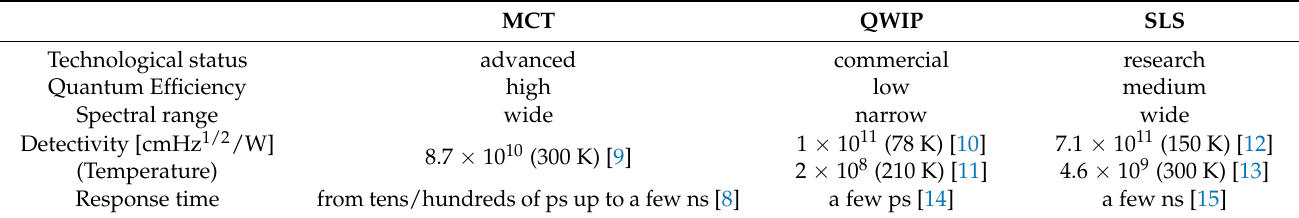
Table 1. Essential properties of some infrared detectors. MCT